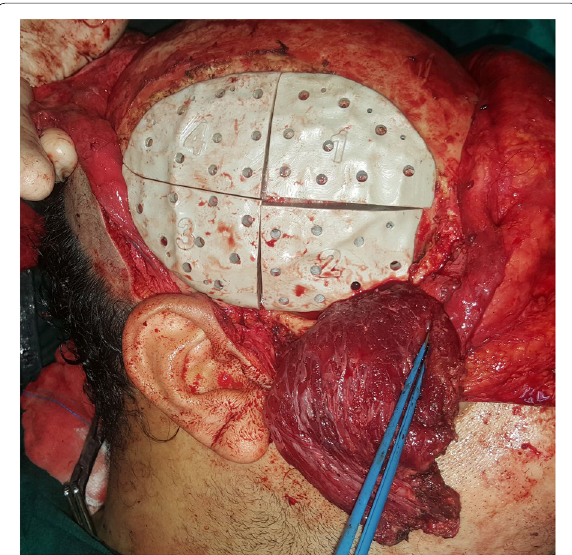
Fig. 6 The temporalis muscle after elevation and the PEEK implant parts initially seated in place